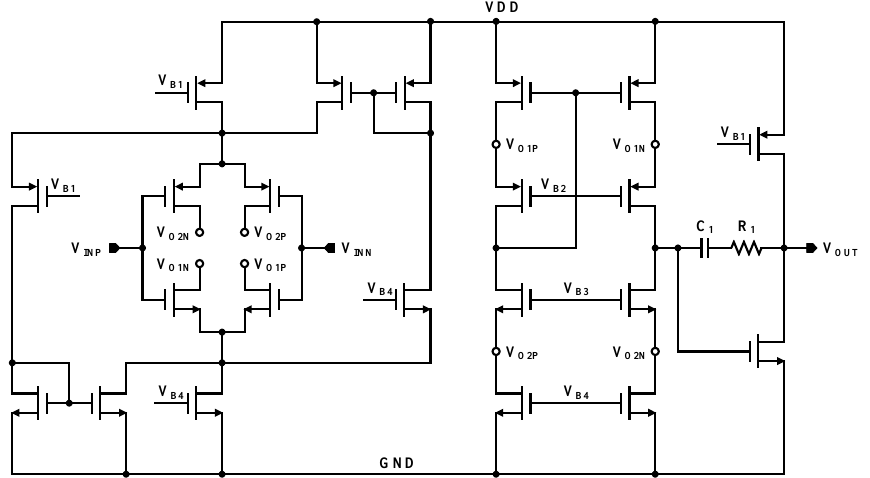
Figure 6. Schematic of proposed differential amplifier.